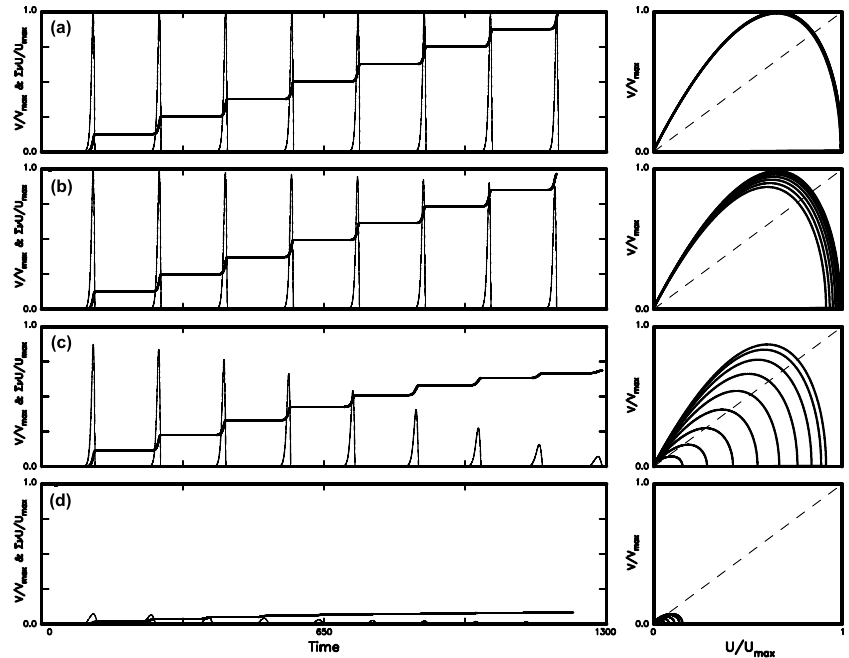
Figure 10. The time variations in V/V max (thin solid line) and cumulative slip (cid:54)U/U max (solid line) and the phase portrait of V/V max versus U/U max (solid line) for four values of C : (a) for C = 0.0001; (b) for C = 0.001; (c) for C = 0.01; and (d) for C = 0.05 when U co = 0.9 and η = 0.